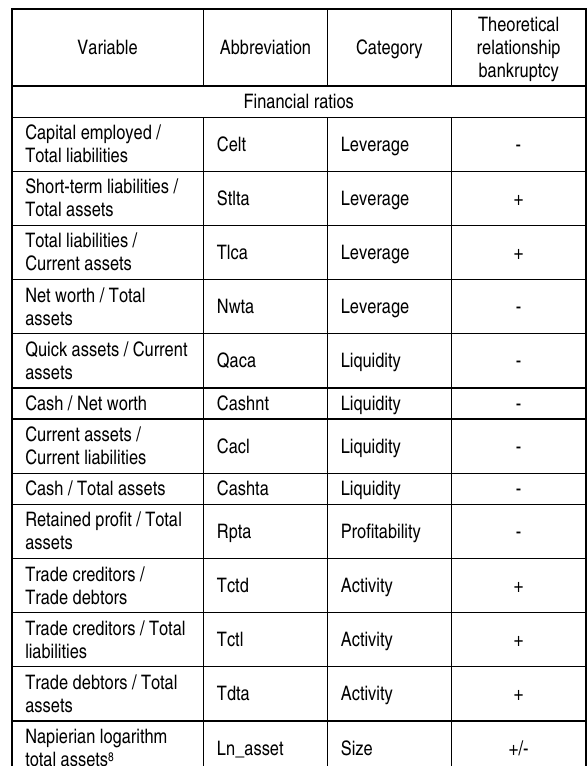
Table 1. Financial, non-financial